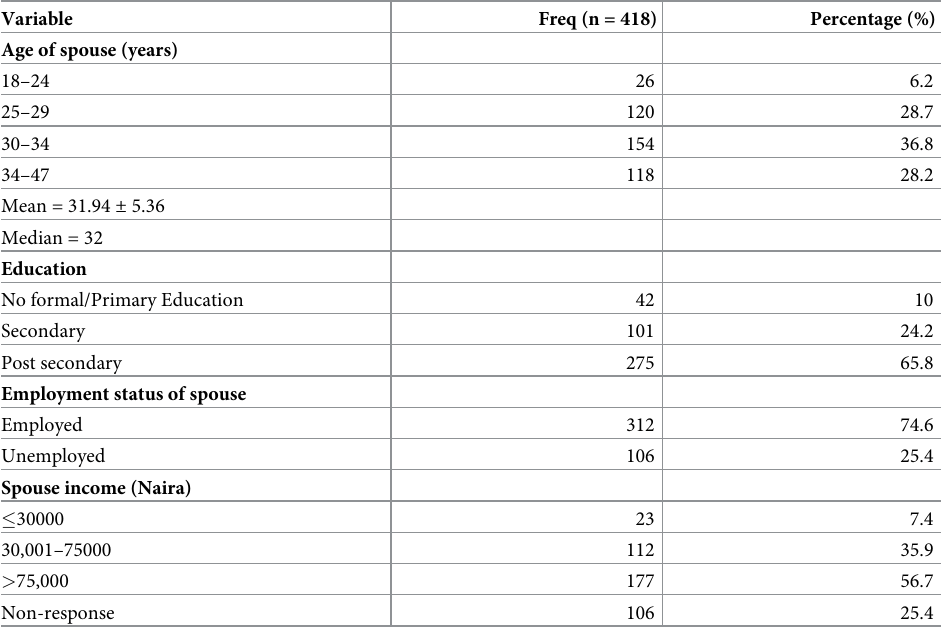
Table 2. Sociodemographic and economic characteristics of